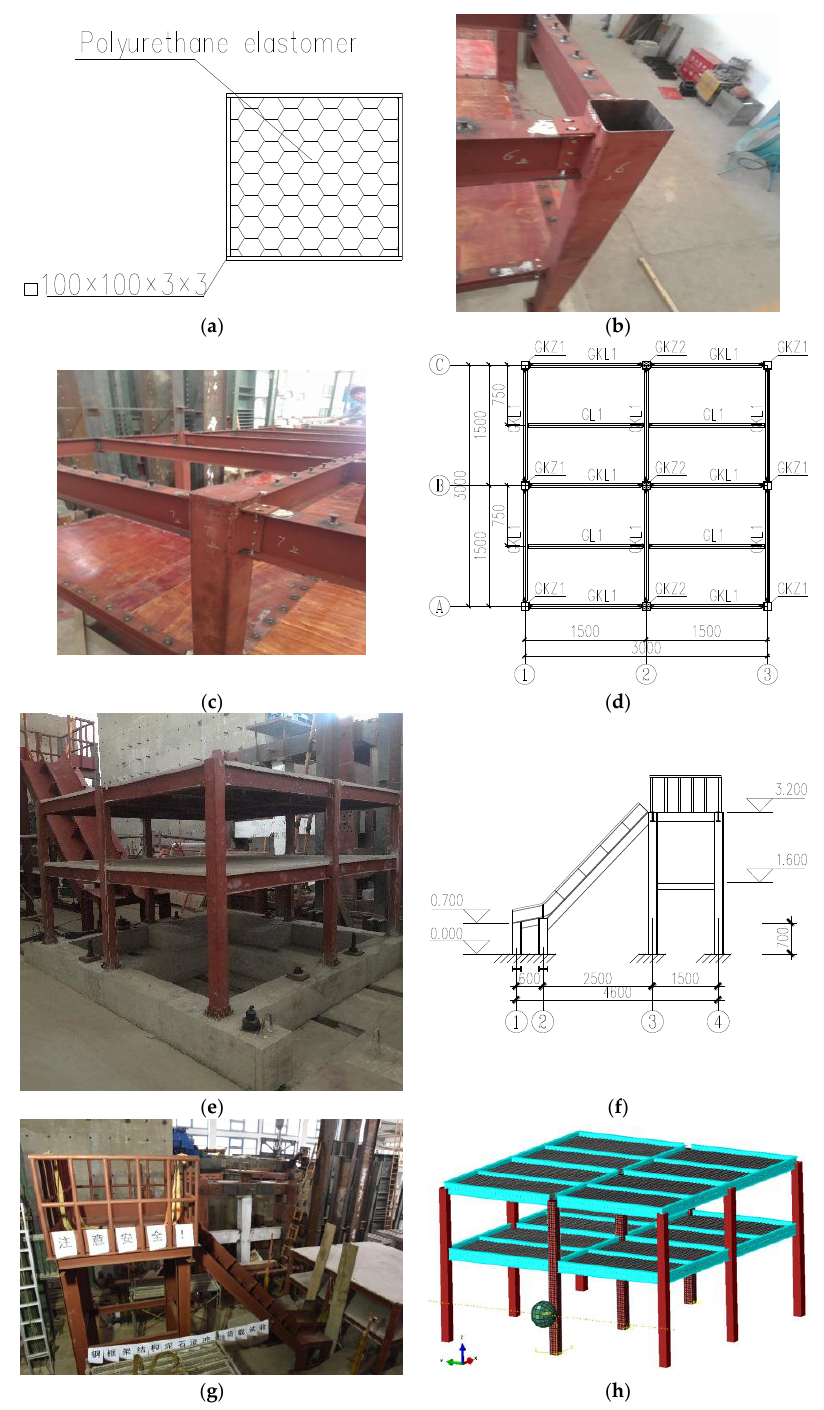
Figure 1. ( a ) Schematic diagram of the polyurethane-steel sandwich column; ( b ) photo of steel frame column; ( c ) photo of polyurethane-steel sandwich column; ( d ) the structural layout of Model B; ( e ) photo of test model; ( f ) elevation of loading device; ( g ) photo of the test site; and ( h ) a 3D schematic of the entire structure.